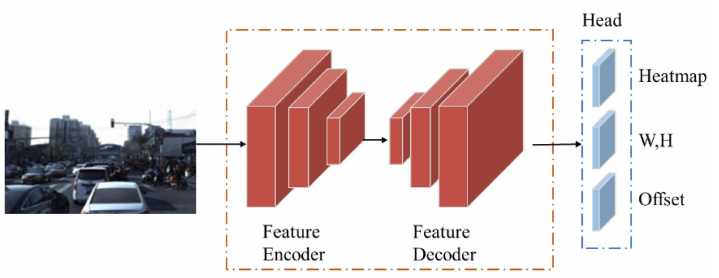
Figure 5. CenterNet network